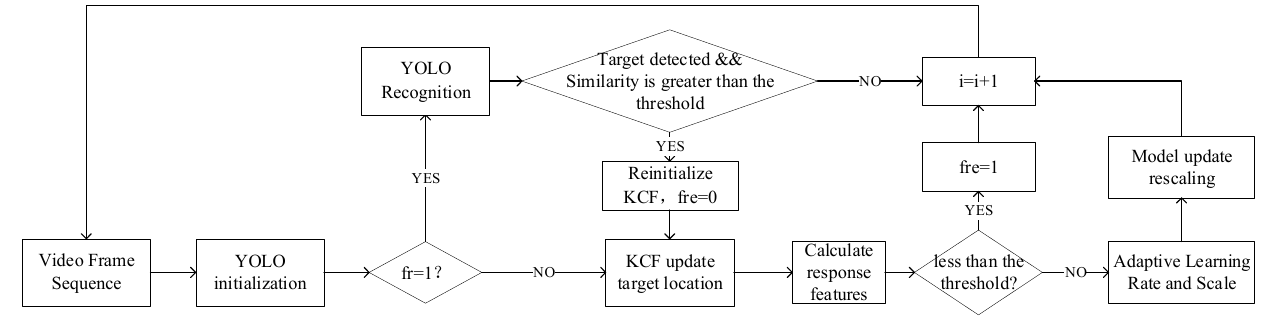
Figure 8. Intelligent re-tracking algorithm with target re-recognition.